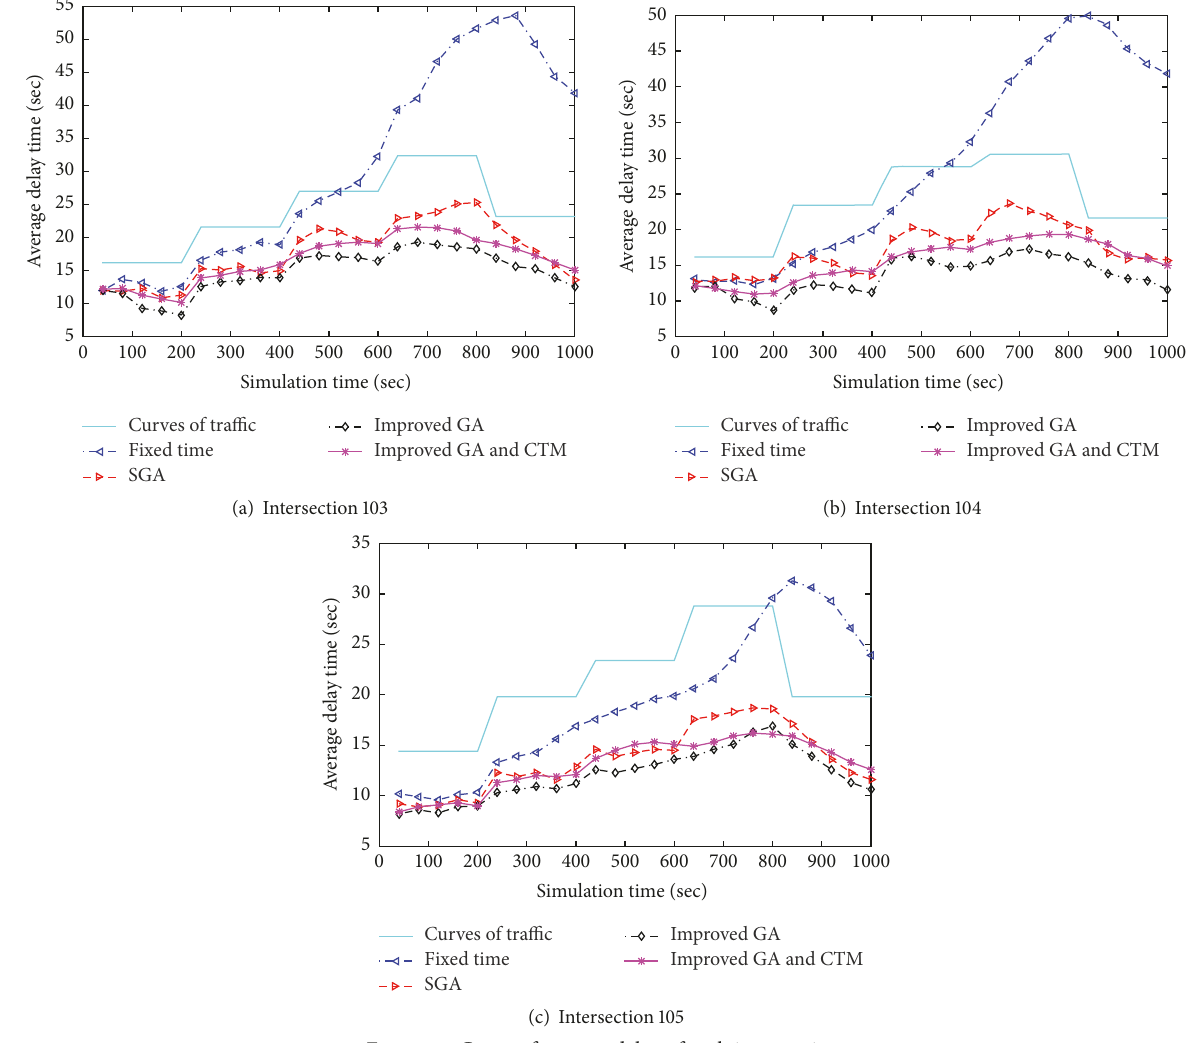
Figure 5: Curve of average delay of each intersection.